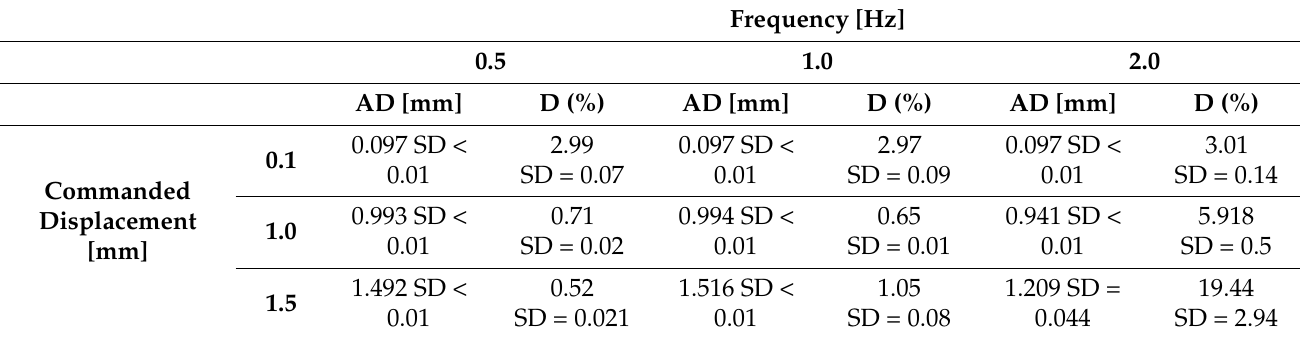
Table 1. Results of the fixator dynamic test. AD—actual displacement; D—difference between actual and commanded displacement as percentage of commanded displacement. The results are reported as mean and standard deviation.